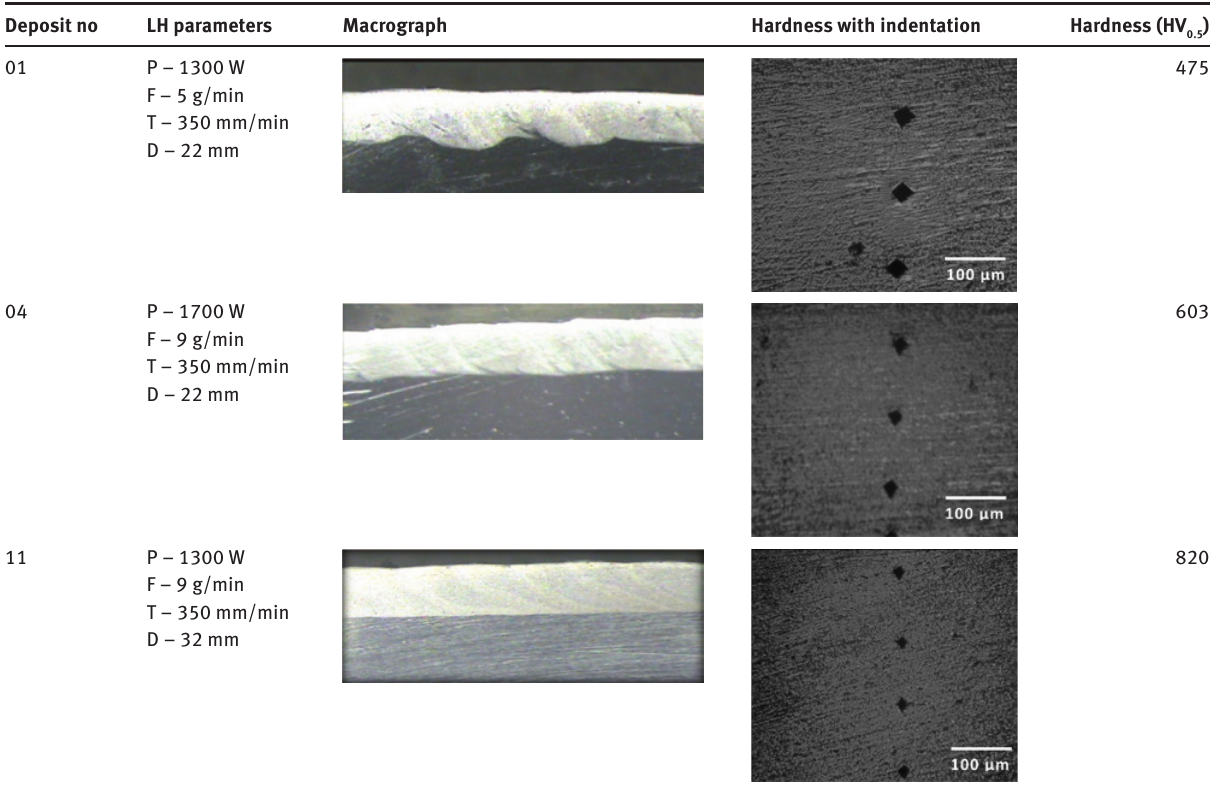
Table 11: Cross-sectional macrograph and top surface hardness indentation of laser hardfaced deposit.